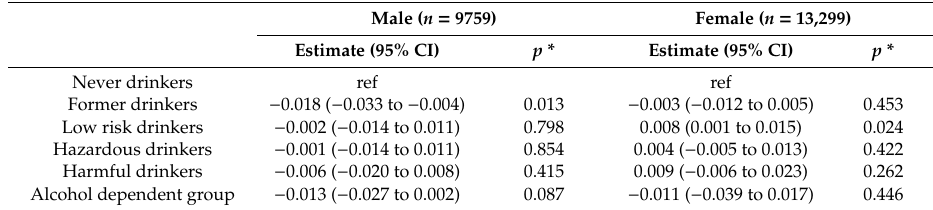
Table 4. Adjusted EQ-5D index score di ff erences associated with alcohol consumption patterns